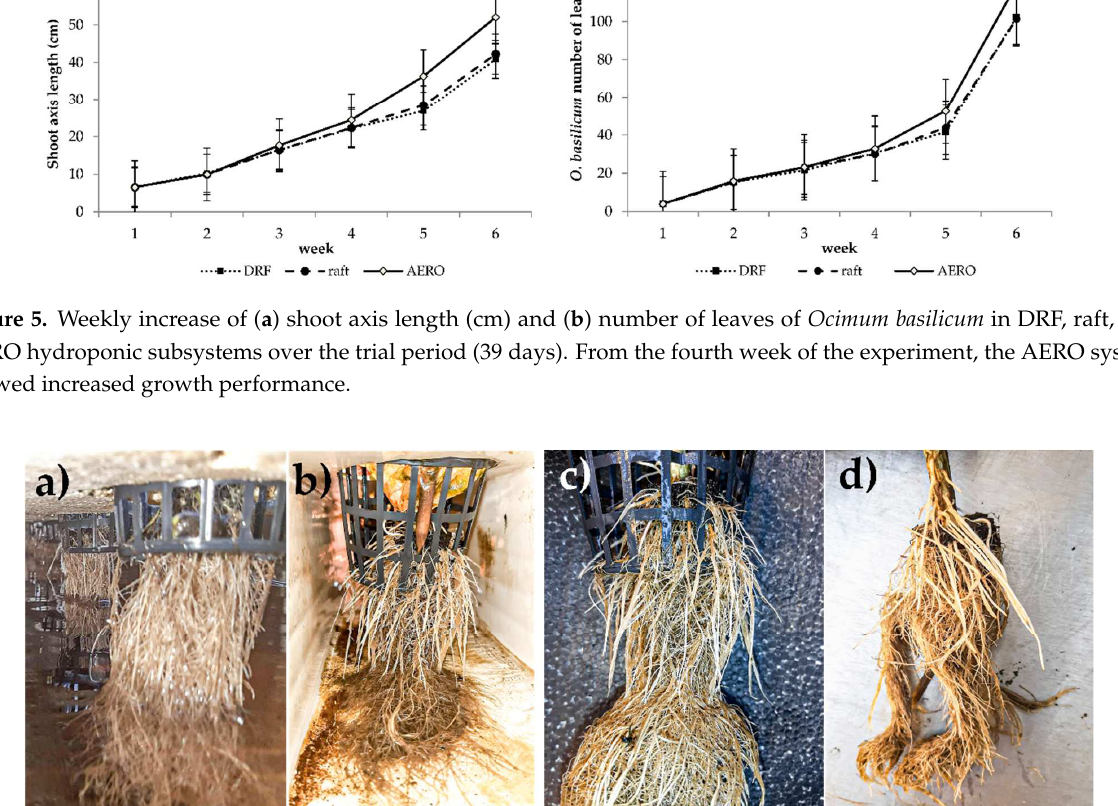
Figure 6. Roots of O. basilicum at the end of the experiment: ( a ) DRF system with roots growing in 5 cm airspace; ( b – d ) roots of the aeroponics system are shorter and tangled but with more lateral roots.